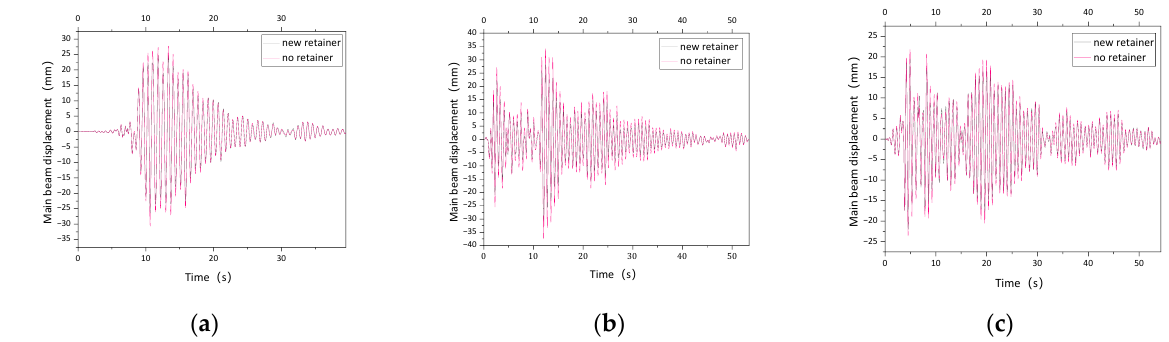
Figure 21. Time-history contradistinction of lateral displacement of main girder (0.1 g).( a ) Imperial valley seismic wave; ( b ) El-Centro seismic wave; ( c ) Taft seismic